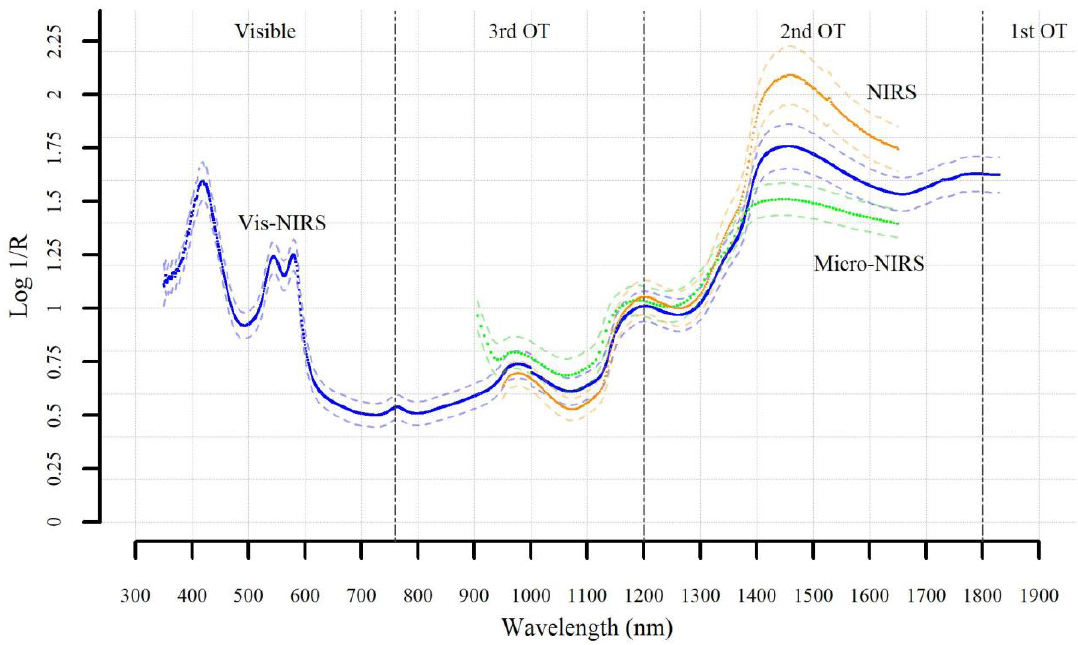
Figure 1. Mean absorbance spectra of 192 beef samples recorded by Vis-NIRS, NIRS, and Micro-NIRS according to wavelength. The spectra show approximately where the first, second, and third overtone (OT) vibrations occur, as well as the visible